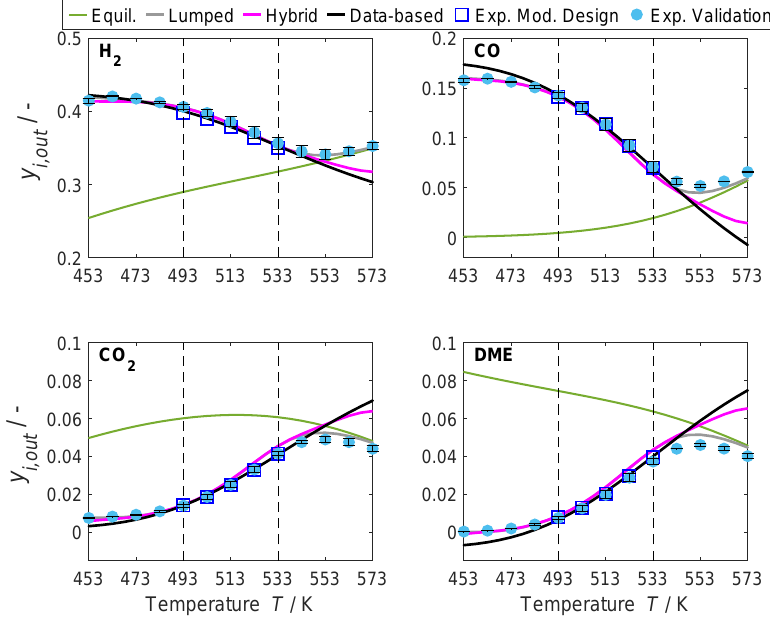
Figure 11. Evaluation of range extrapolation by comparison of models’ predictions and experimental results beyond the models’ validity range for temperature. Feed composition: 42.3% H 0.82% CO . Total gas flow 0.2 slpm. Pressure 50 bar. CZA-to- γ -Al 2 26